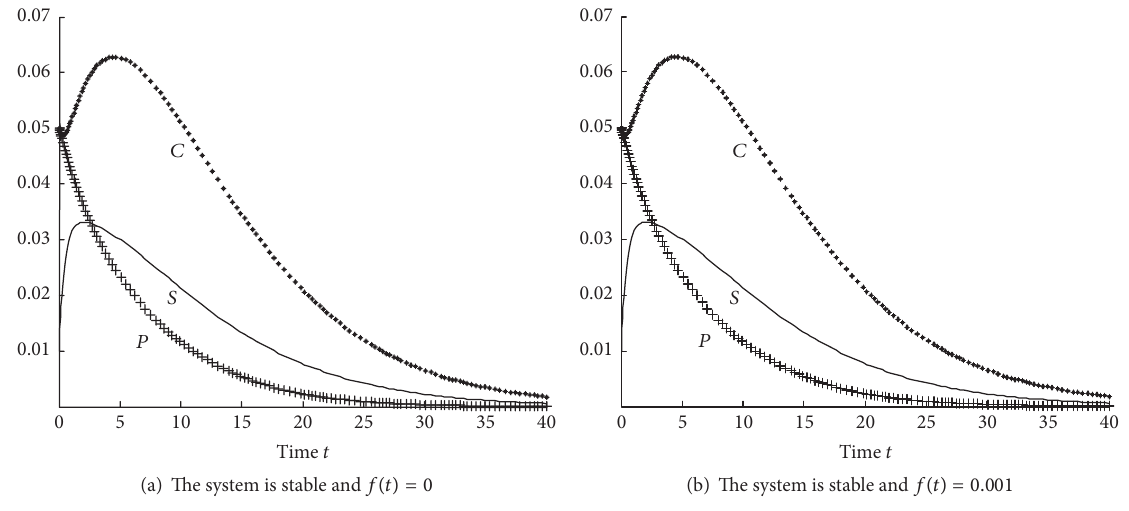
Figure 1: Variation trends of parameters and resource elements under system